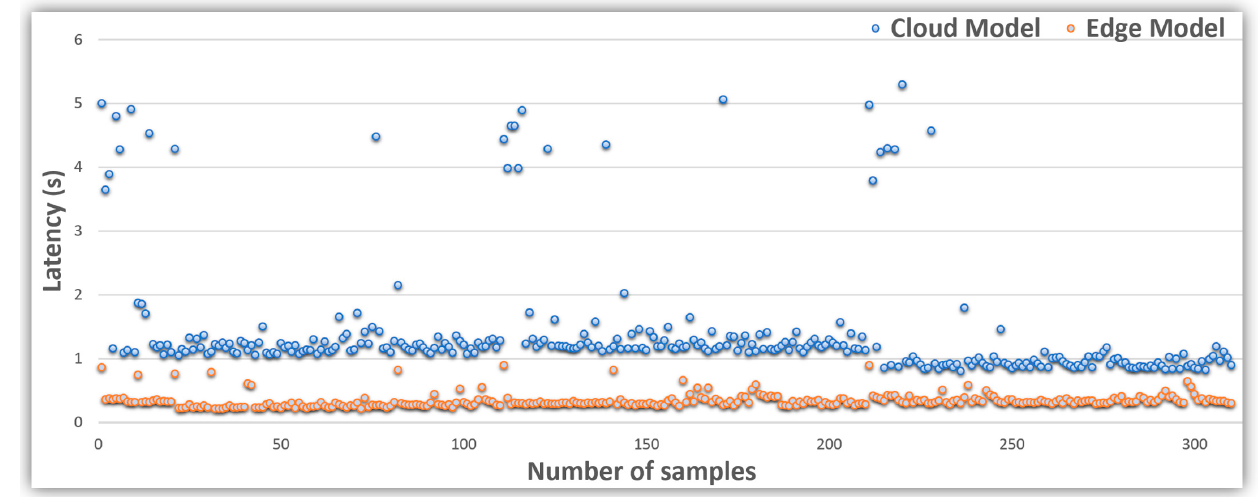
Figure 10. Latency of more than 300 samples.